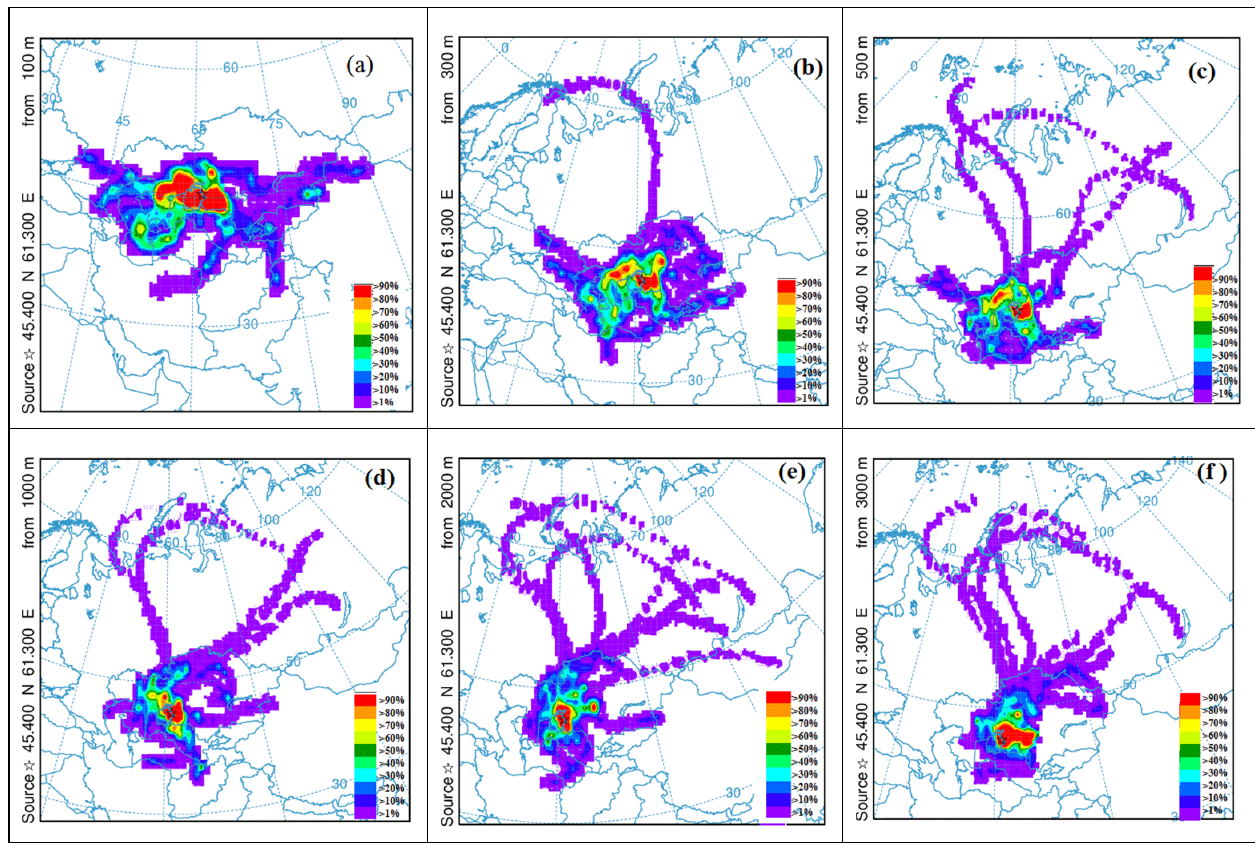
Figure 4. Occurrence frequency of 72 h of forward trajectory of air masses starting from different AGL (above ground level) of dried bottom of the Aral Sea: ( a ) 100 m agl.; ( b ) 300 m agl.; ( c ) 500 m agl.; ( d ) 1000 m agl.; ( e ) 2000 m agl.; ( f ) 3000 m agl.